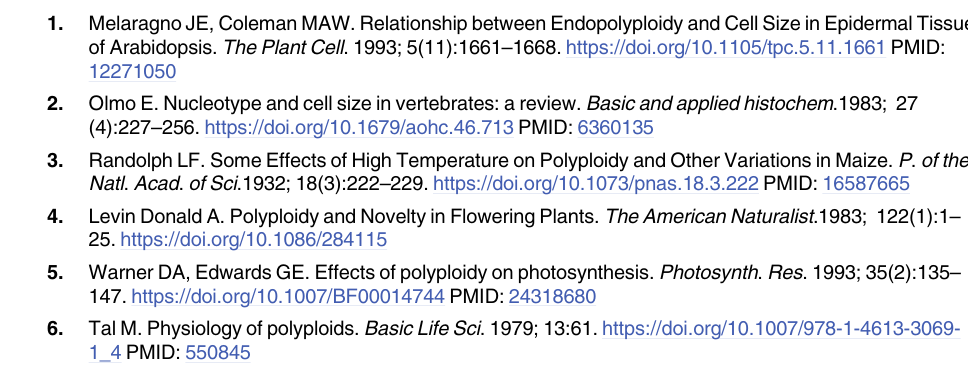
S1 Table. Primers used in quantitative real-time PCR. S2 Table. DEG KEGG pathway. S3 Table. Number of up-regulated genes and down-regulated genes in differential genes.